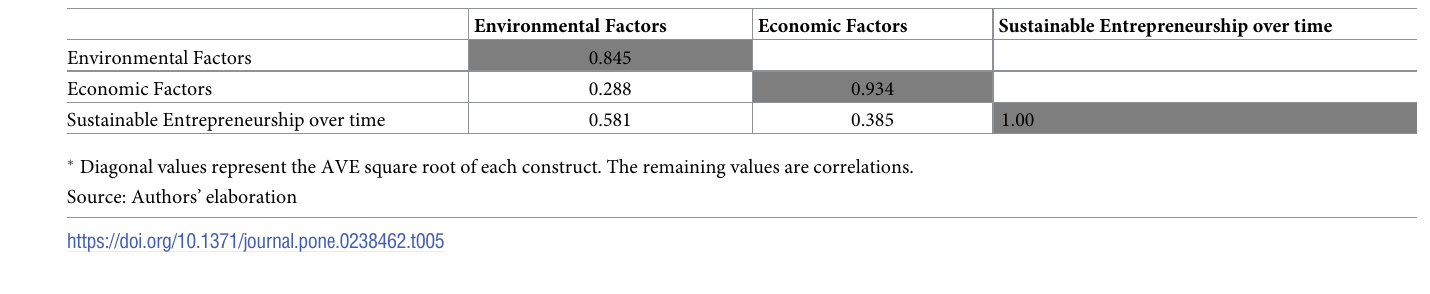
Table 5. Discriminant validity. Fornell-Larcker